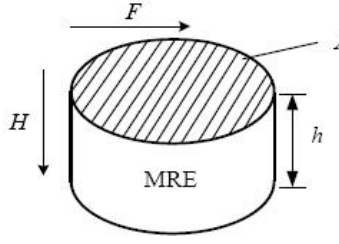
Figure 5. MREs working in the shear mode.